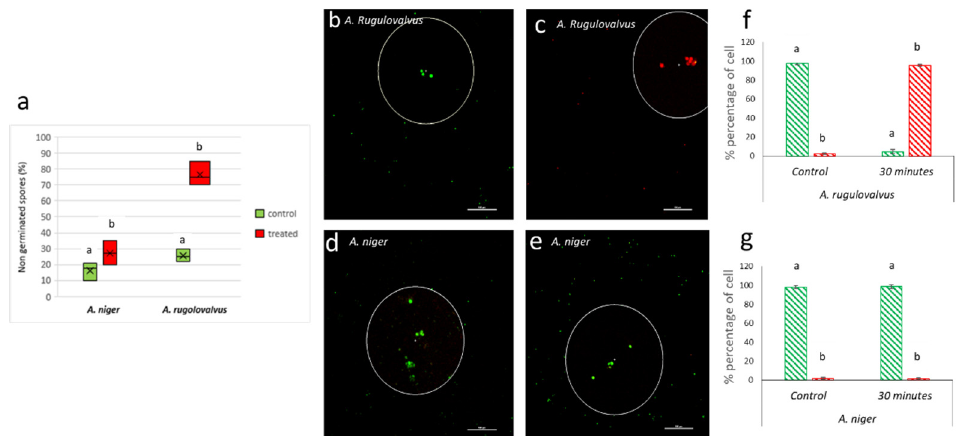
Figure 2. Effect of ACP on spore germination ( a ) of Aspergillus niger and A. rugulovalvus in malt extract medium after 30 min of ACP treatment. Confocal laser scanning microscopy analysis of cell viability in A. rugulovalvus ( b , c ) A. niger ( d , e ) after treatment and stained with green fluorescence CFDA (carboxyfuorescein diacetate) and red propidium iodide (PI) dyes. Bars indicate percentage of cell live (green) and death (red) spores in A. rugulovalvus ( f ) and A. niger ( g ), respectively. Different letters represent significant differences between the sample ( p < 0.05; Tukey HSD post-hoc test).